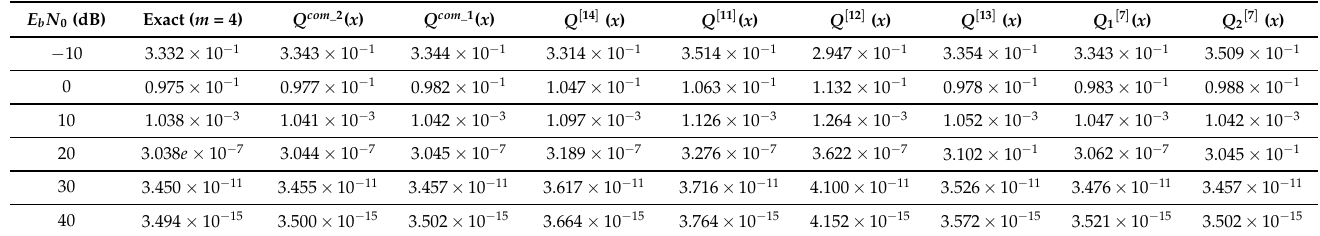
Table 4. Comparison of ASEP values over Nakagami- m fading channels for parameter m = 4, obtained by applying our Q -function approximations and selected ones from the